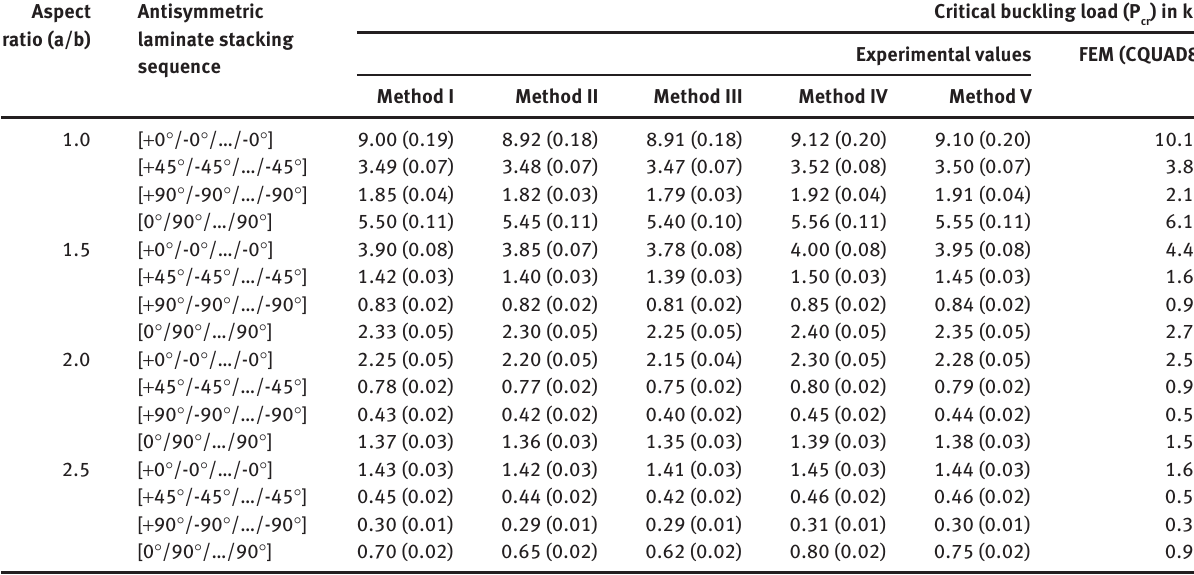
The numbers in parentheses represent the standard deviation.